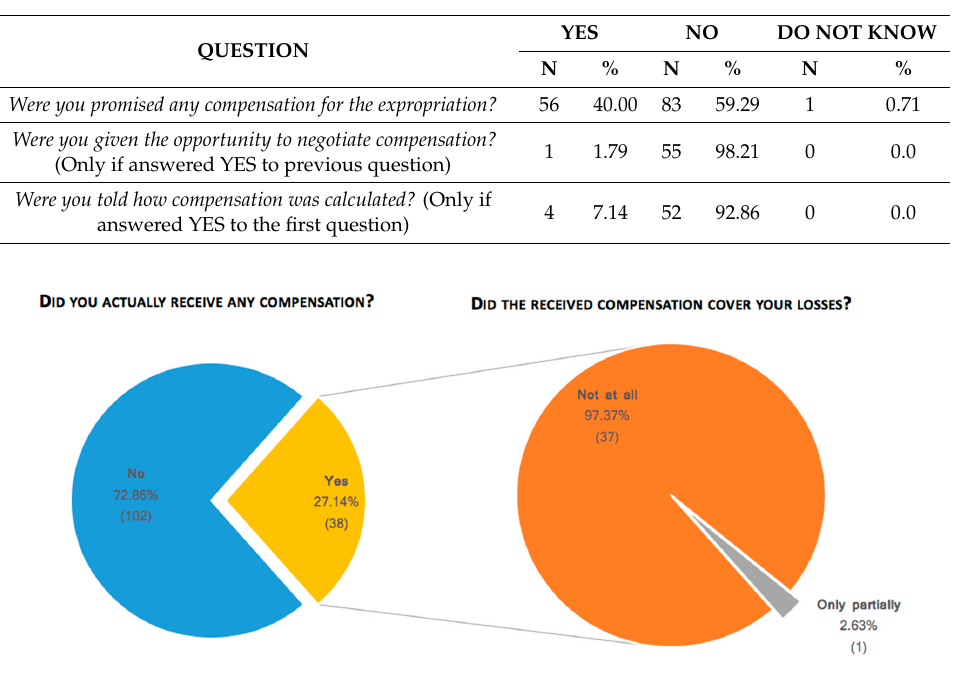
Figure 2. Actual compensation and level of satisfaction (n = 140 respondents).